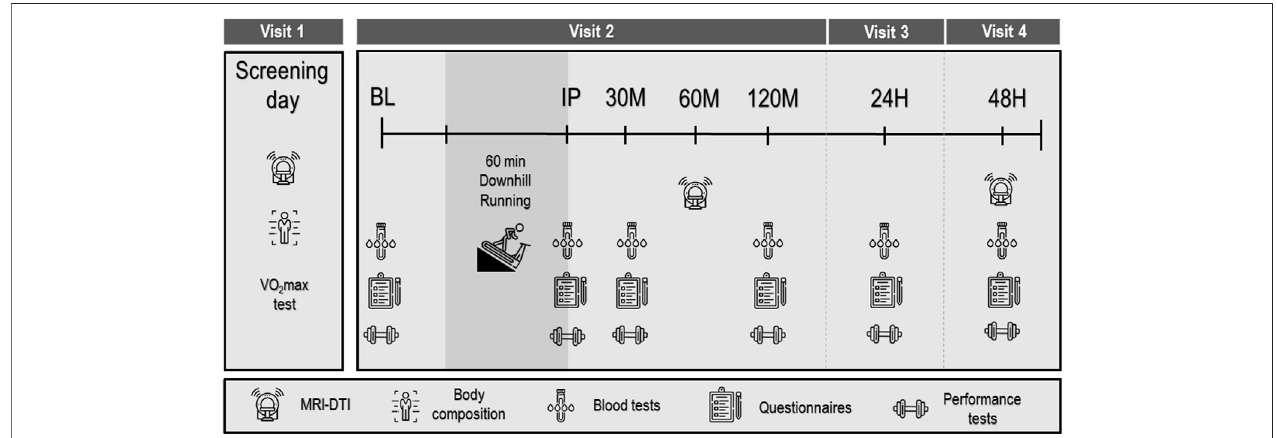
FIGURE1| Experimentalprotocol.Baseline(BL),immediatelypost(IP),30 min(30 M),120 min(120 M),24 h(24H)and48 h(48H)postdownhillrunningprotocol. VO2max: maximal O2 consumption; MRI-DTI: magnetic resonance imaging diffusion tensor